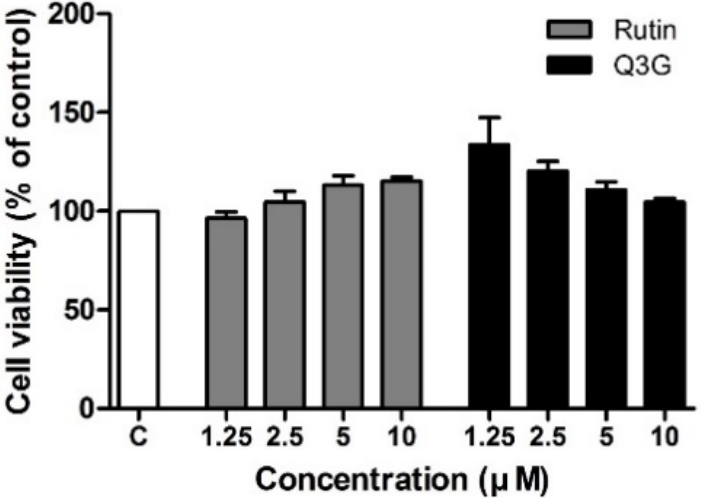
Figure 2. Effect of rutin and quercetin-3- O - β - D -glucoside (Q3G) on cell viability of 3T3-L1 adipocytes treated for 48 h. Data are means ± standard error of the mean (SEM, n = 3).